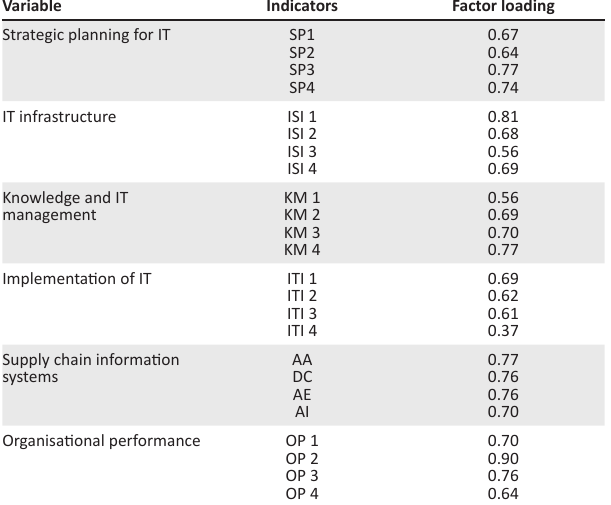
Variable Indicators Factor loading Strategic planning for IT